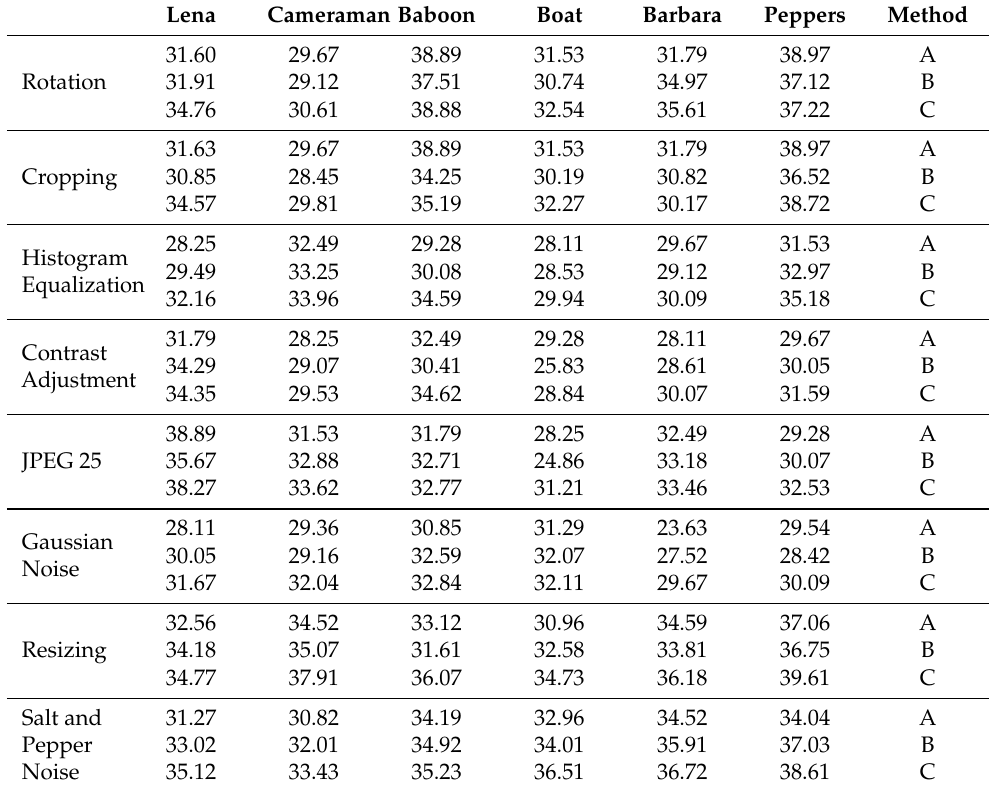
Table 3. Peak signal to noise ratio (PSNR) values after common attacks (A: DWT, B: Block DWT, C: FSF Block DWT).